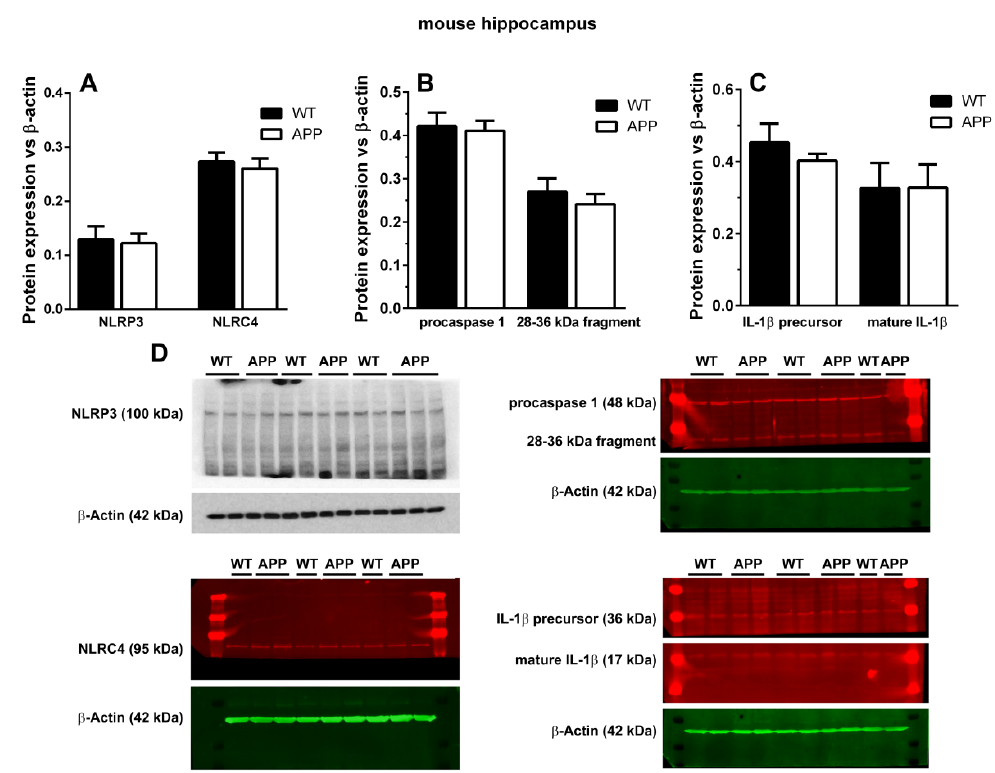
Figure 3. No changes in the expression of neural components of active inflammasomes and of mature IL-1 β were detected in HP of APP/P versus WT. Panels ( A – C ) show quantitative Western blot analysis of NLRP3 and NLRC4 ( A ), proforms of caspase-1 ( B ), and IL-1 β precursor and its active form ( C ). Note that there are no significant changes of these proteins in APP/P versus WT. ( D ) shows a representative Western blot of NLRP3, NLRC4, procaspase-1, Il-1 β precursor, mature IL-1 β , and their respective β -actin as charge control. In the case of caspase-1, a band of 48 kDa, which corresponds to procaspase-1, and another band below 36 kDa ( B , D , 28–36 kDa fragment) are observed. Results represent the mean ± SEM of 3 to 5 independent mice in each experimental group.